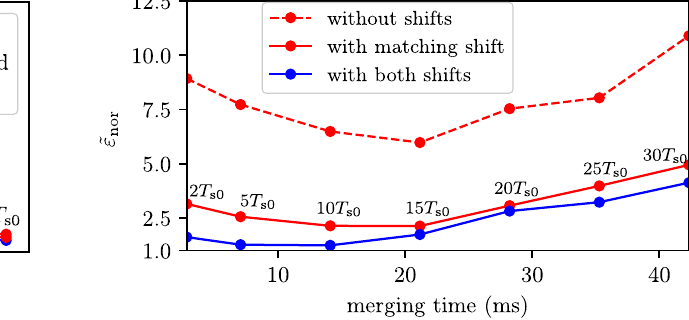
FIG. 11. The normalized emittance of two bunches after bunch merging in the presence of beam loading and space charge with , 10 T , 5 T , 3 T , and 1 T , in s 0 s 0 s 0 s 0 s 0 ¼ 2 T ; 5 T ; 10 T ; 15 T ; 20 T ; 25 T different merging times t m s s s s s s and 30 T : (i) without shifts (dashed red); (ii) with matching s shift, without symmetry shifts (solid red); (iii) with both shifts (solid